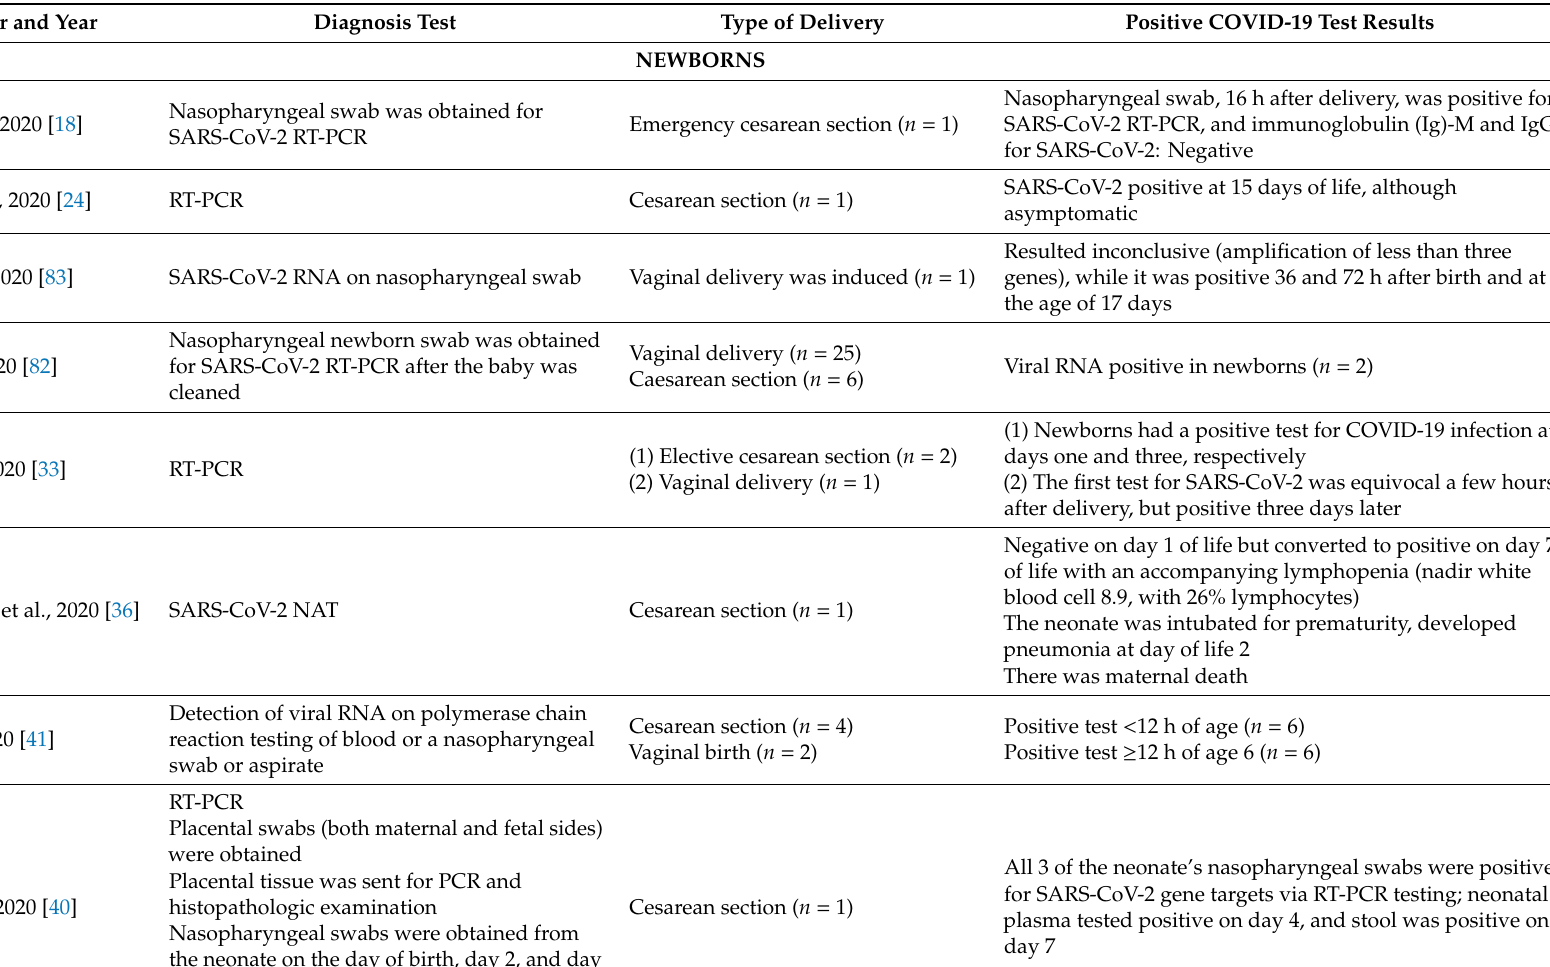
Table 3. Results for newborn placentas and breast milk that tested positive for SARS-CoV-2 after